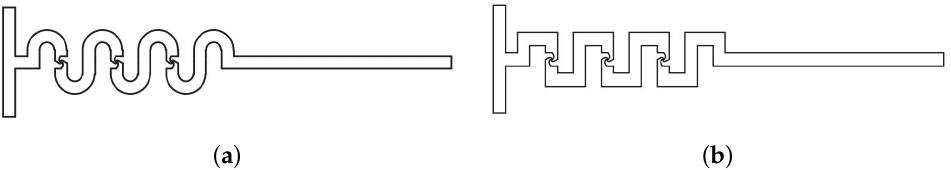
Figure 2. ( a , b ) Illustration of the structure complexity of different microdevices. (Reprinted from Chemical Physics Letters , Volume 734, Yao Chen and Xueye Chen, An improved design for passive micromixer based on topology optimization method, 136706, Copyright (2019), with permission from